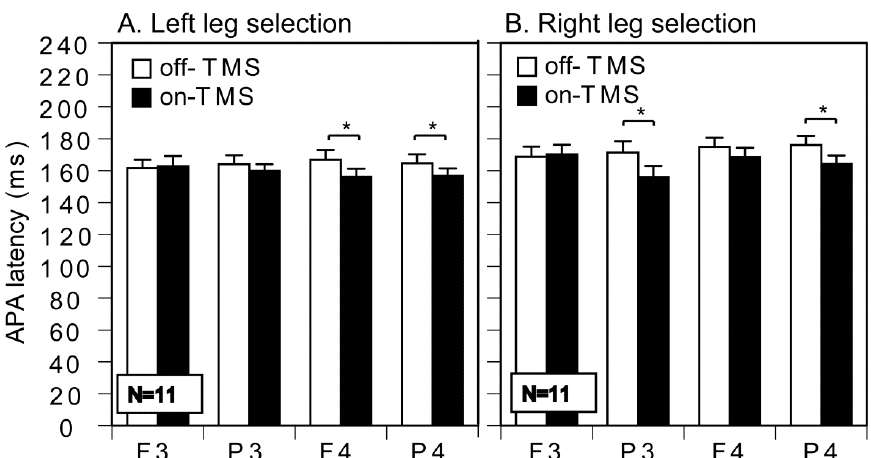
Figure 3. The APA latency of the tested gait initiation with the left ( A ) and right legs ( B ). The bars indicate the mean and the error bars indicate the standard errors of the mean. Asterisks indicate that the APA latency in the on-TMS condition was significantly shorter than that in the off-TMS condition (test of the simple main effect; p < 0.05).